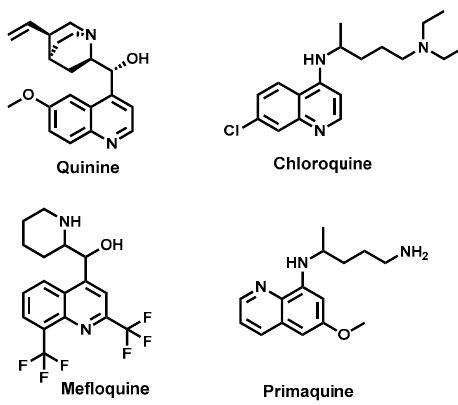
Figure 16. Antischistosomal cinchona alkaloids and derivatives.